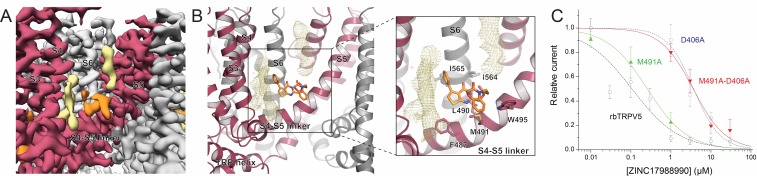
ZINC17988990 interaction with the S4-S5 linker.(A) Cryo-EM density map of the ZINC17988990 binding pocket in the S4-S5 linker. Density attributed to ZINC17988990 is shown in orange. Lipids are colored in khaki. The TRPV5 protein is depicted with one monomer in red and three in gray. (B) (left) Atomic model of the ZINC17988990 binding pocket in the S4-S5 linker. (right) Zoomed in view of the ZINC17988990 binding pocket with residues that could constitute binding labeled and shown as sticks. One potential pose of the ZINC17988990 molecule is shown as orange sticks and annular lipids are shown as khaki mesh. (C) Summary of the effects of ZINC17988990 on wildtype TRPV5 (black, replotted from Figure 1F), D406A TRPV5 (blue, replotted from Figure 4C), M491A TRPV5 (green, n = 5–6) and M491A-D406A TRPV5 (red, n = 6) analyzed and plotted as in Figure 1.